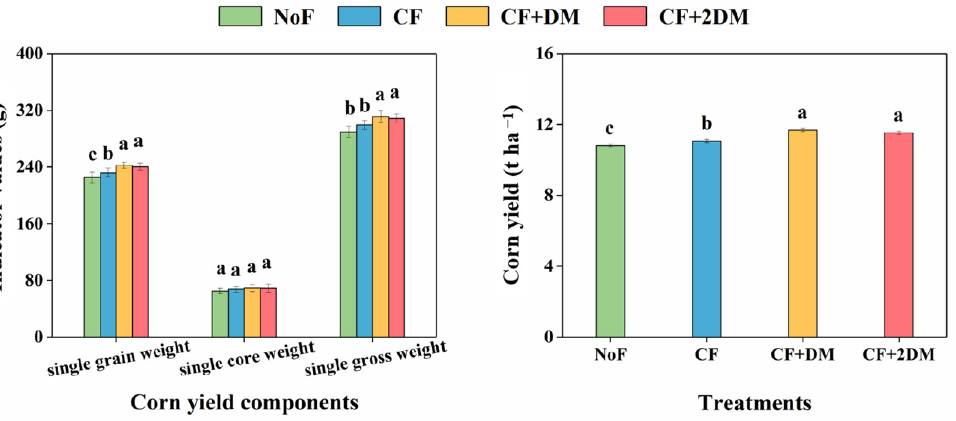
Figure 5. Responses of corn yield components to different fertilization managements in 2019. In the same soil layer, the various letters of the same fraction exhibited significant differences at the p < 0.05 level via Tukey’s HSD test under the four treatments. NoF, non ‐ fertilizer. CF, only chemical fertilizer. CF + DM, chemical fertilizer plus with single dairy manure. CF + 2DM, chemical fertilizer plus with double dairy manure.